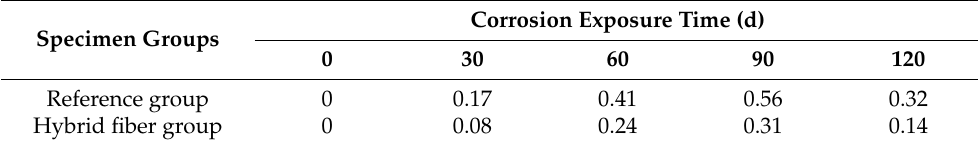
Table 10. Mass change factors of specimens at different corrosion exposure (%).